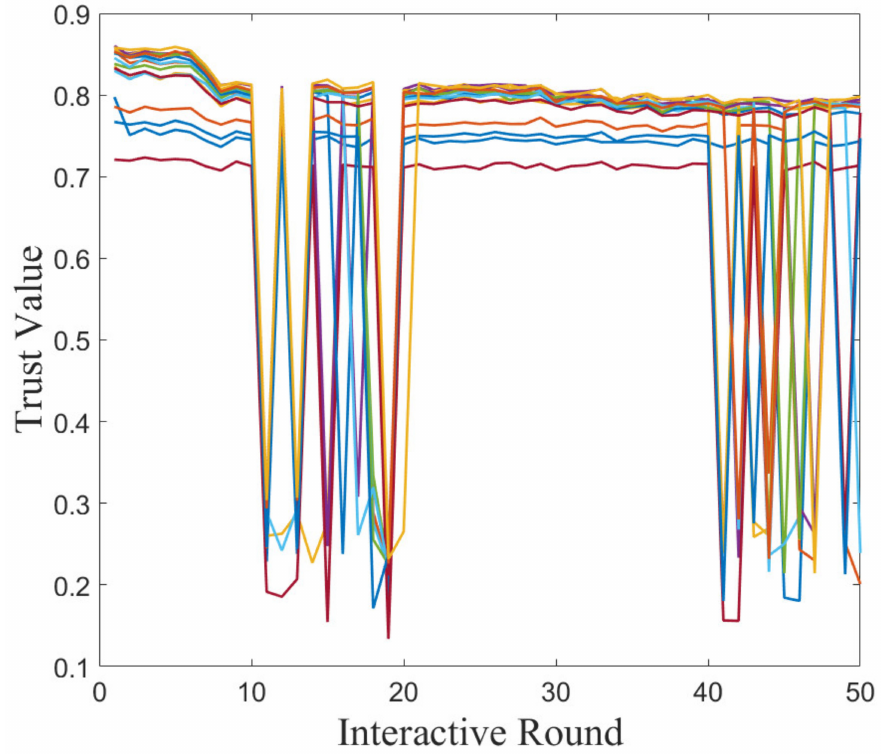
Figure 11. Trust value of LFCTEM under ON-OFF attack